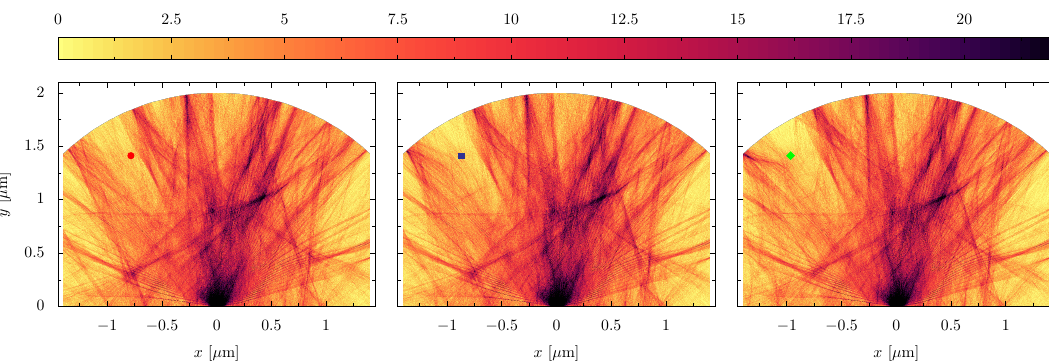
Figure 6: Density of classical trajectories in the weakly disordered sample of Fig. 2, modified by a Lorentzian bump at three different positions and strengths on the fea- ture shown in Fig. 5. The position of the tip is indicated by the colored symbols in the panels, that allow to identify the parameters with the ones of the marked points in Fig.